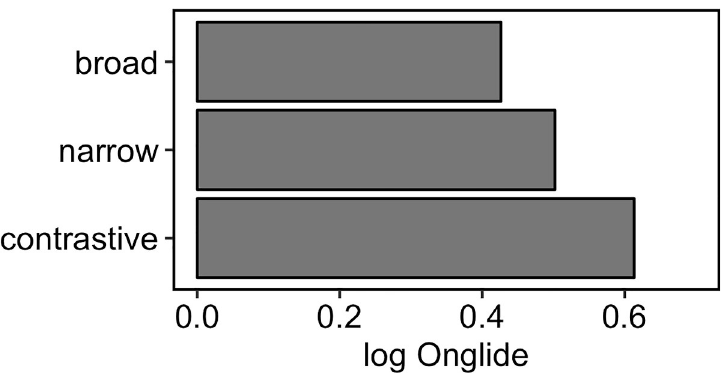
Fig 11. Medians of the rising normalised onglide distributions for the three focus types pooled across all speakers.